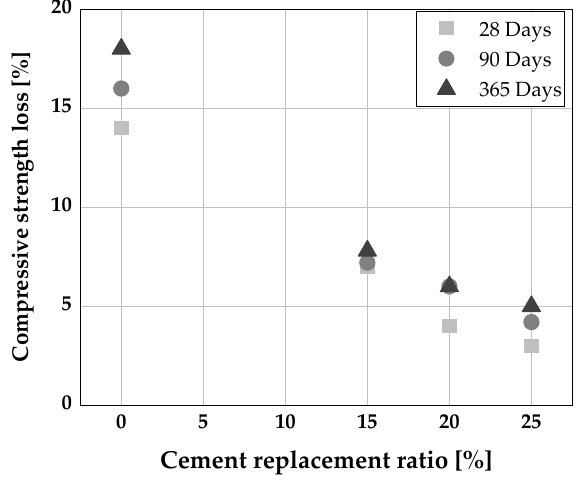
Figure 14. Compressive strength loss of SCC [135].